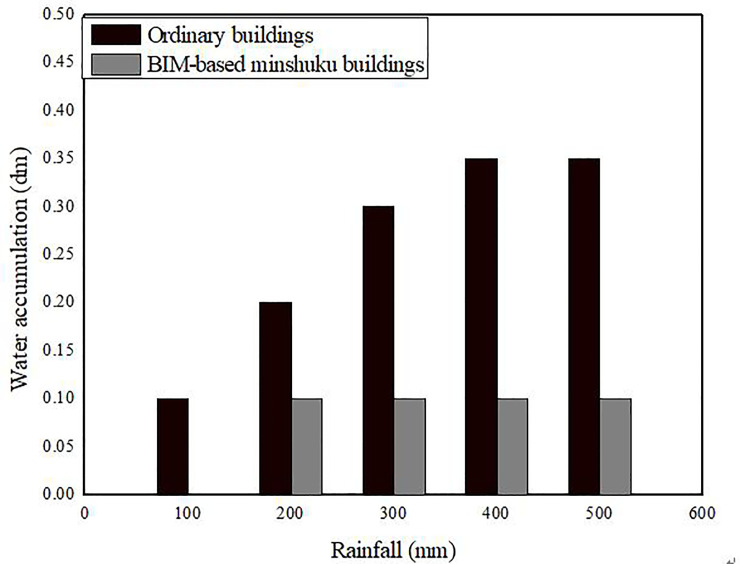
The ponding of homestay based on BIM in the case of rainstorms.